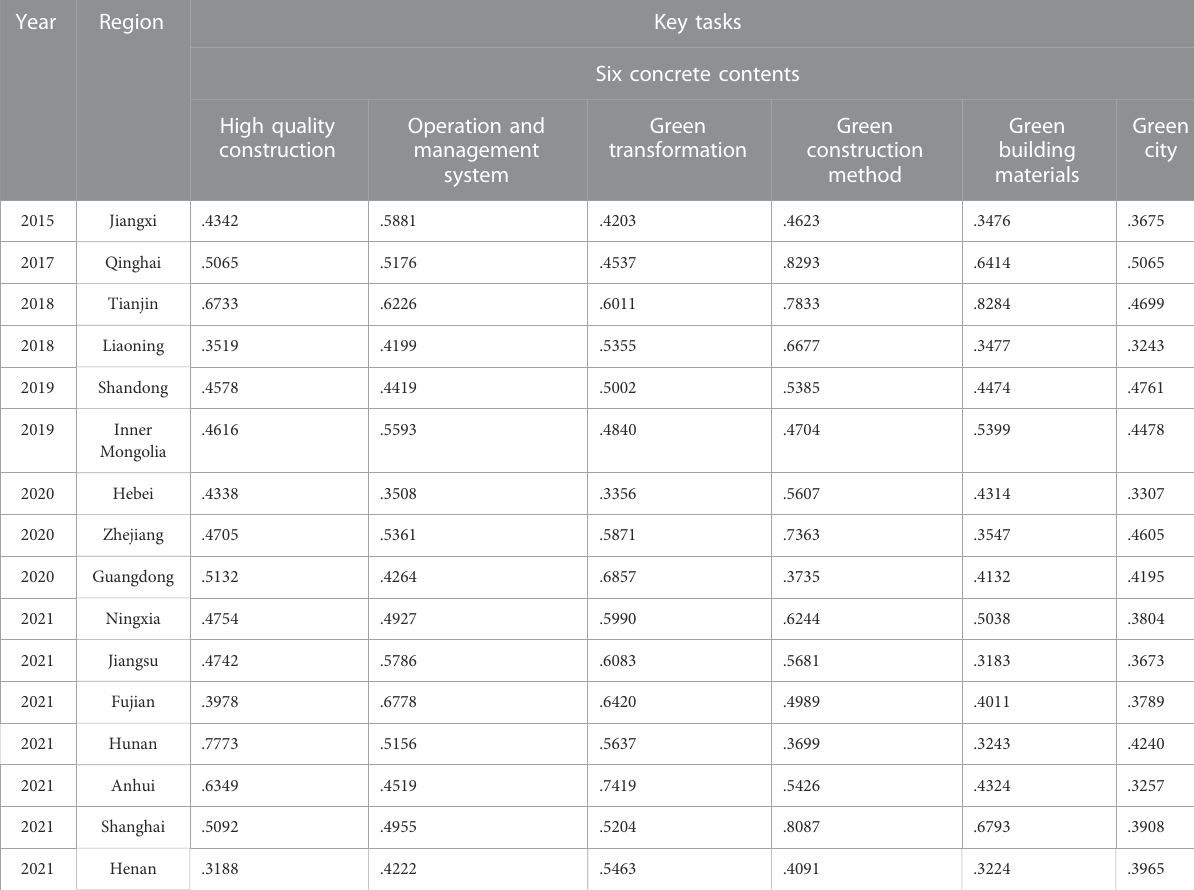
TABLE 3 Comparison of similarity values of key tasks of green